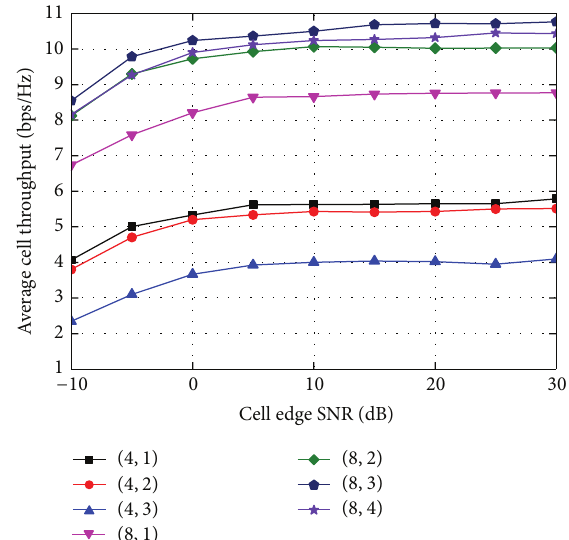
Figure 6: Cell throughput for DUSIA with different (𝑁,𝜉) versus cell edge SNR.